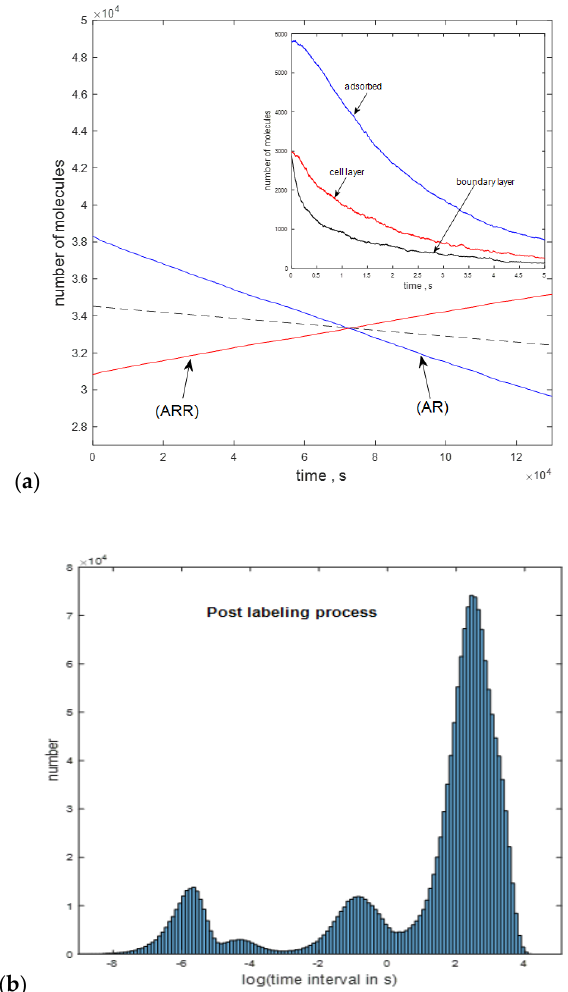
Figure 4. ( a ) The evolution of the labeling reaction populations after the labeling reaction was stopped. The dashed line is proportional to the sum (AR) + (ARR) = (ABC); ( b ) distribution of time intervals between reactions in the post-labeling process. The long intervals are associated with the dissociation reactions of AR and ARR. ABC = antibodies bound to the cell.